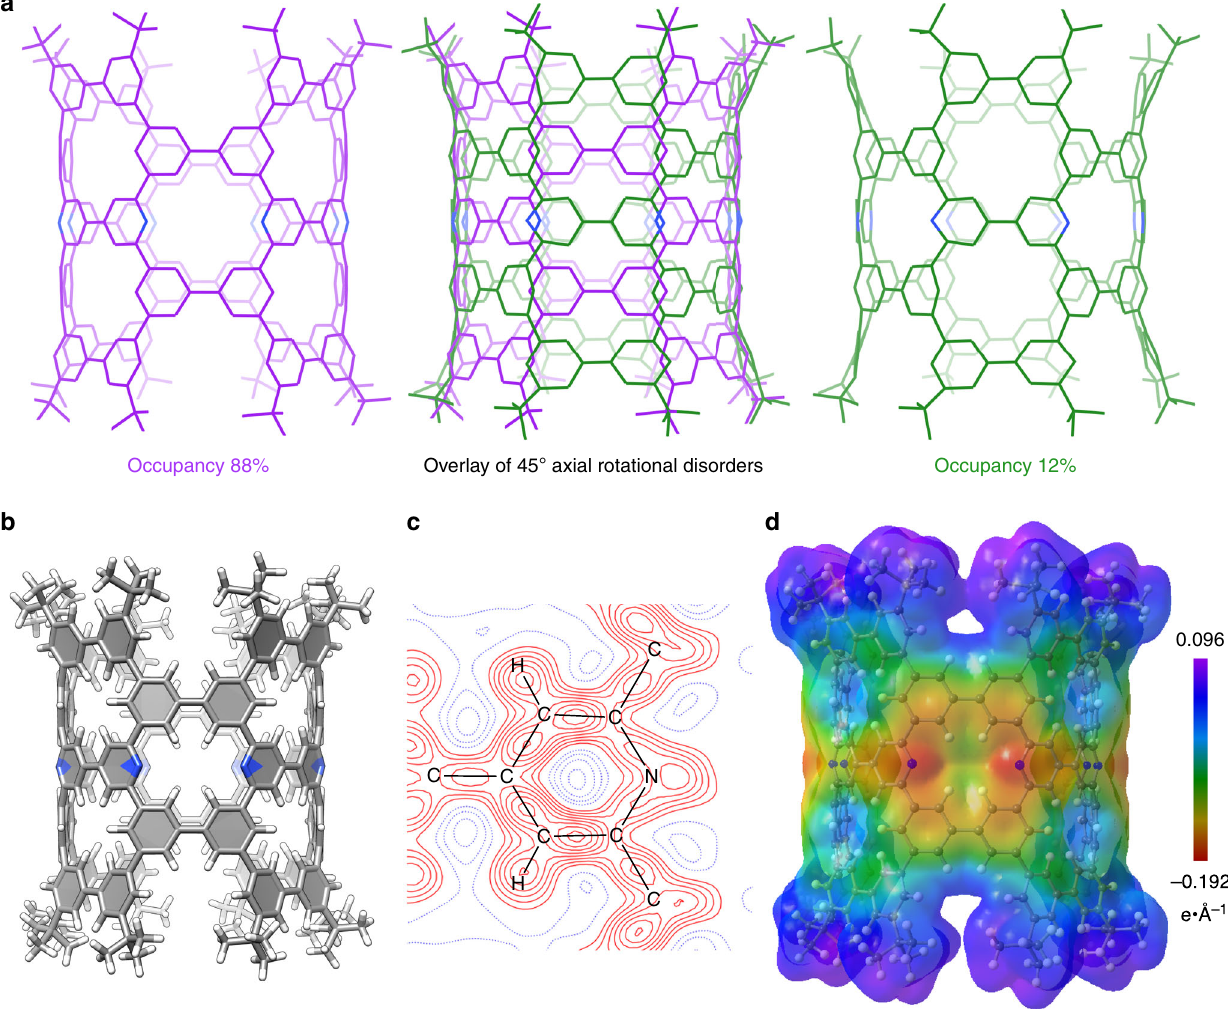
Fig. 3 Crystal structures of (12,12)-NpNT. a Molecular structures of two disordered structures. b Molecular structure (occupancy = 88%). c Deformation map (contour interval: 0.02 e Å − 3 , positive: red, negative: blue). Note that, because of the lower occupancy of 12%, negligible densities of the minor disordered structure were found in the electron and deformation density map, which also resulted in distortions of the assigned structures. See also Fig. 3a and Supplementary Fig. 5. d Electrostatic potential map mapped on the 0.0067 e Å − 3 isosurface of the electron